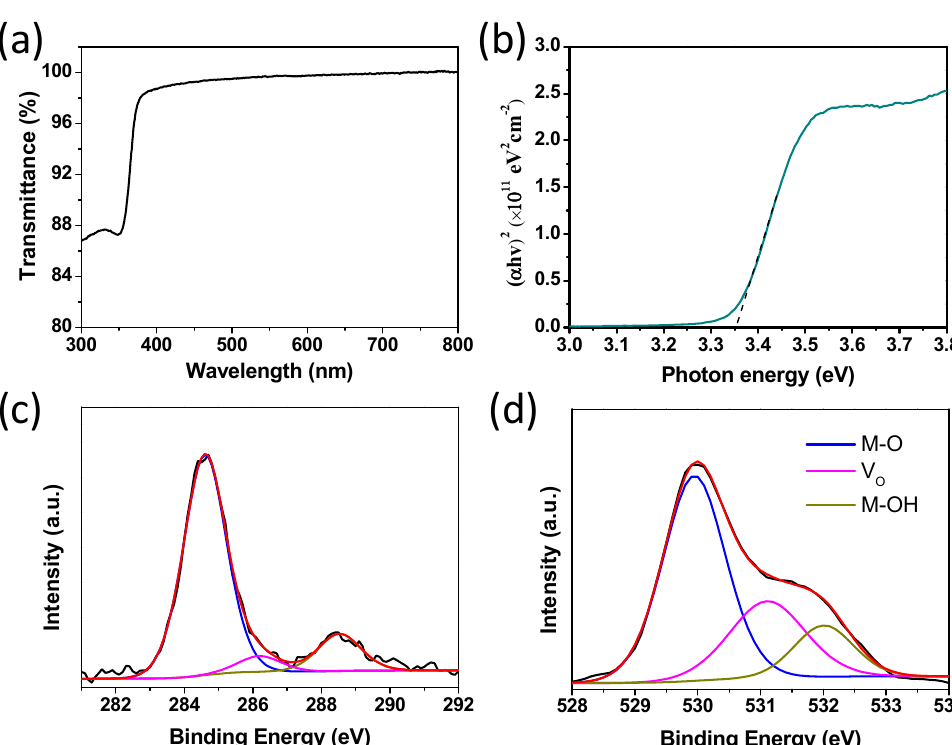
Figure 1. ( a ) Optical transmission spectrum of the ZnO thin film on the sapphire substrate. ( b ) The absorption coefficient as a function of photon energy of ZnO thin film annealed at 300 °C. X-ray photoelectron spectroscopy (XPS) spectra of the C1s ( c ) and O1s ( d ) core level lines for the solution processed ZnO thin film annealed at 300 °C.